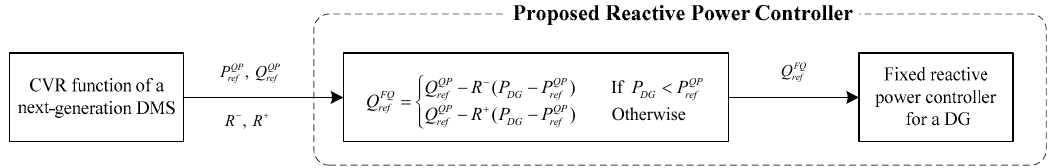
Figure 3. Outline of the proposed reactive power controller.